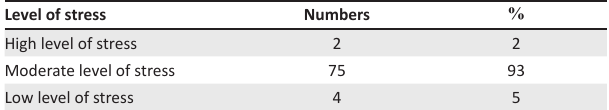
TABLE 4: Level of stress for factors causing stress.